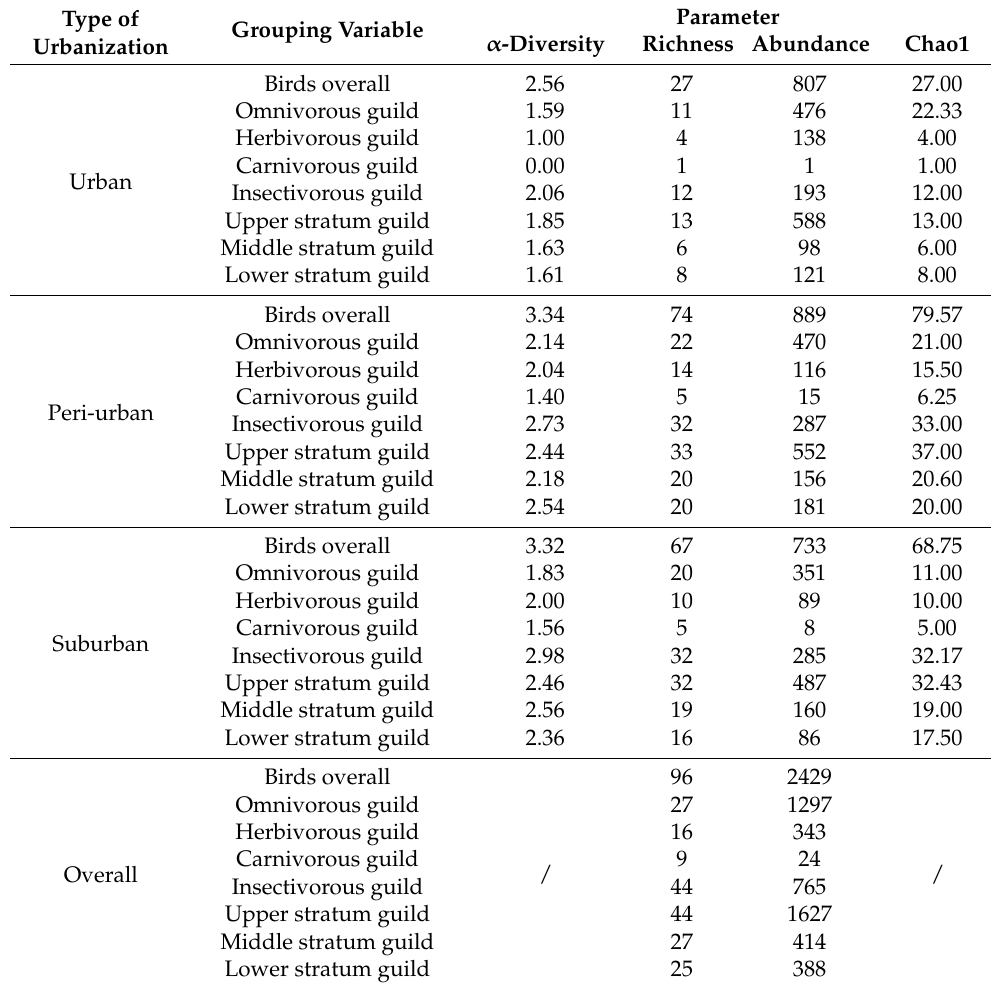
Table 1. Bird guilds in mountain parks under three urbanization gradients, including α -diversity, richness, abundance, and Chao1